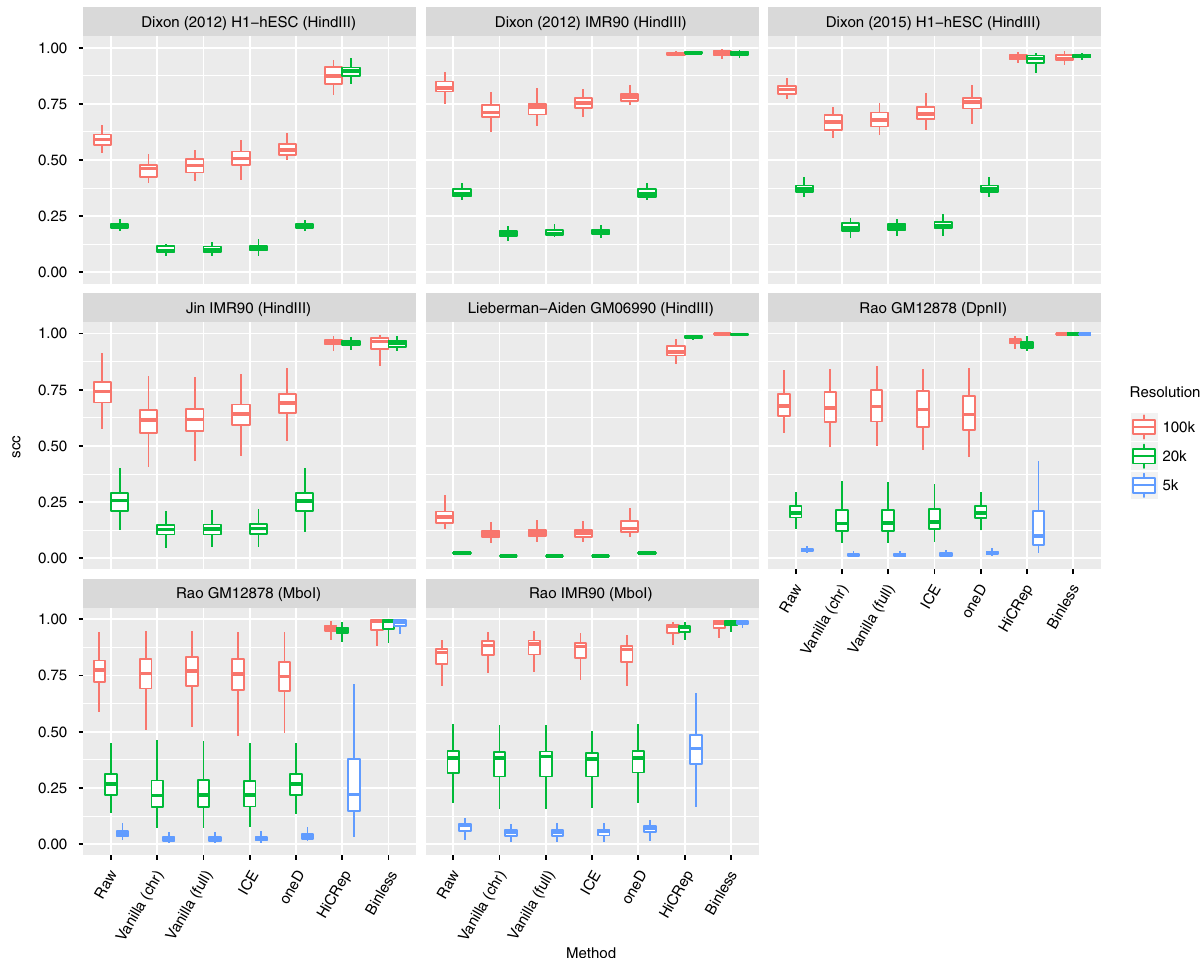
Fig. 2 Binless matrices show high correlation across biological replicates. Here we report the strati fi ed correlation coef fi cient (SCC) between two biological replicates. The SCC was computed on each chromosome, for each resolution, normalization method, and dataset. Boxplots show the distribution of SCC values across a large number of comparisons (see methods for details, Sup. Table panel 3 for comparisons and panel 8 for sample